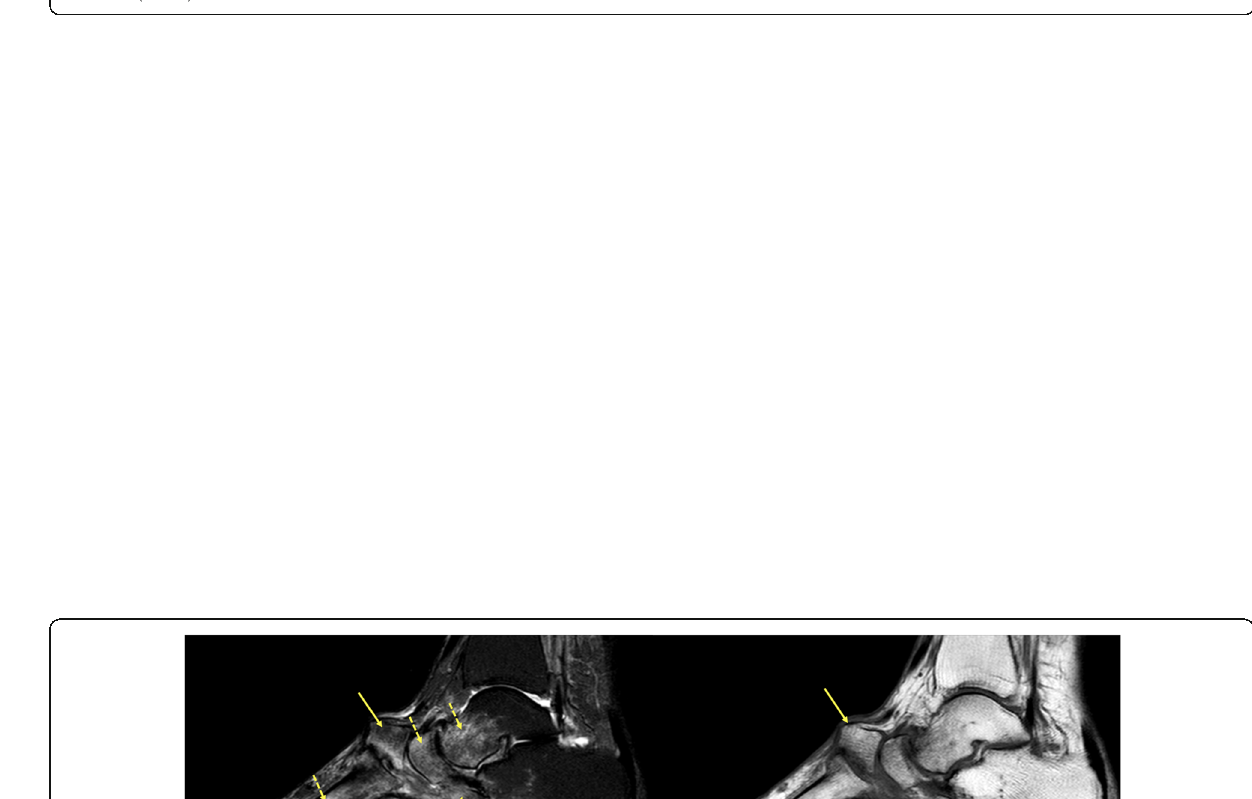
Fig. 28 A 70-year-old female with diabetes and Charcot foot. MRI showed extensive bone marrow edema (dashed arrows) in all bones of the foot suggesting active Charcot changes, most prominent at the level of the Lisfranc joint, where dorsal dislocation of os cuneiforme intermedium is visible (arrow)